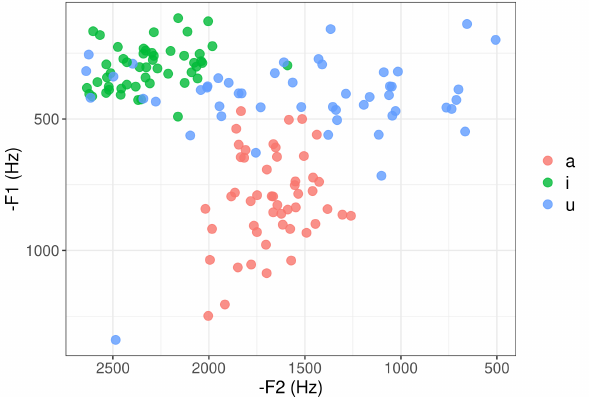
Figure 1. The distribution of formants for the vowels [a], [i], and [u] for Italian in the recordings of the data set. Each point represents an occurrence of a vowel in the recordings. The formant values indicate the formants observed at the central point for each occurrence of each